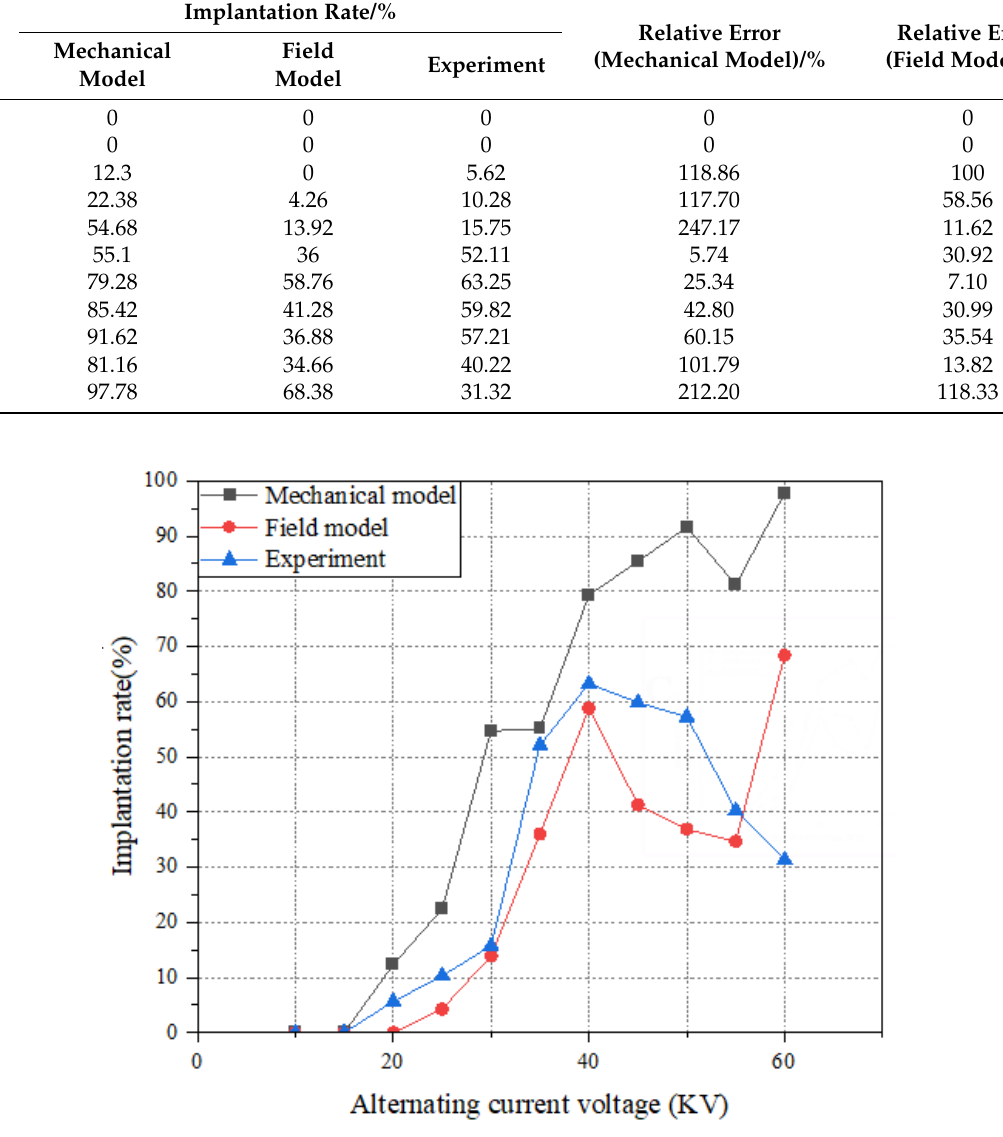
Figure 14. Comparison of the number of particles at different